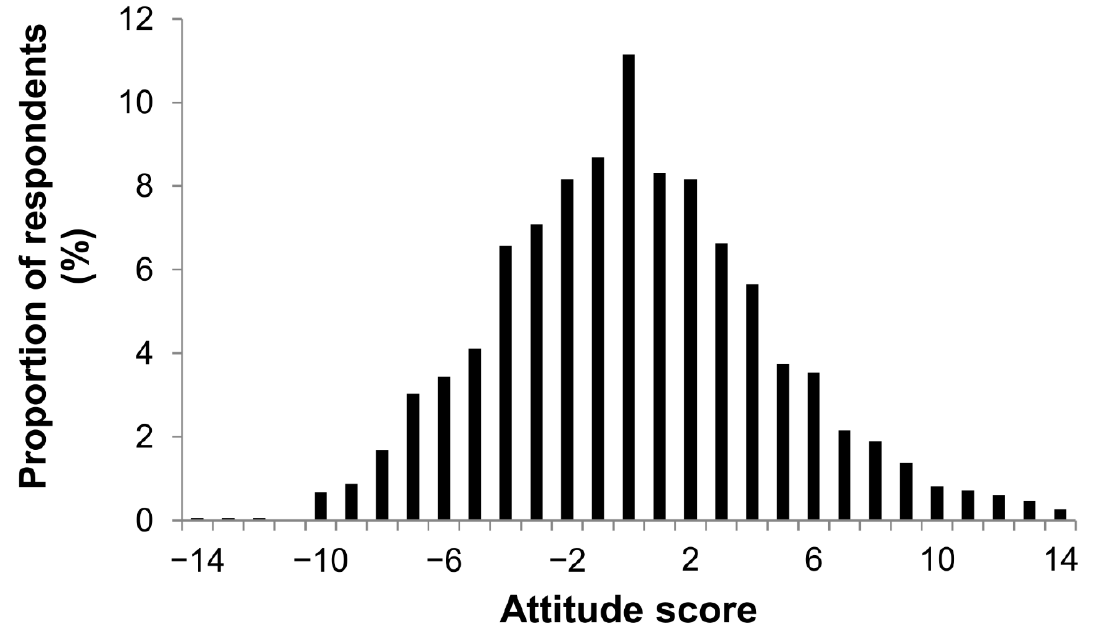
Figure 1. Histogram showing the proportion of young Polish respondents with each attitude score. Attitude score was tallied on seven attitudinal items with respect to hunting and hunters and ranged from − 14 to 14 (see Table 1). Data were collected in 2020 from a random sample of 1947 Polish high school students. Table 2. Average attitude scores of young Polish respondents (n = 1947) in relation to their socio- demographic characteristics, forest and hunting experience, socialization, and social network. The at- titude score was calculated based on seven attitudinal items, and the attitude scale was centered on 0 (ranging from − 14 to 14). Different letters indicate significant